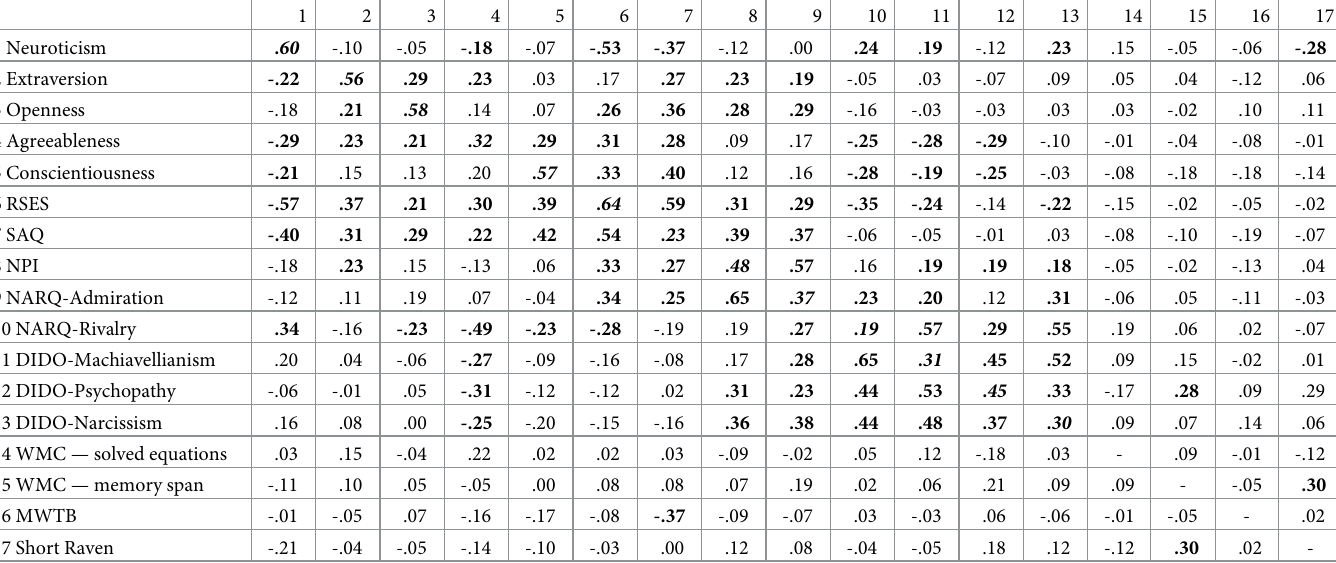
Table 14. CONNECT selected traits and cognitive abilities.